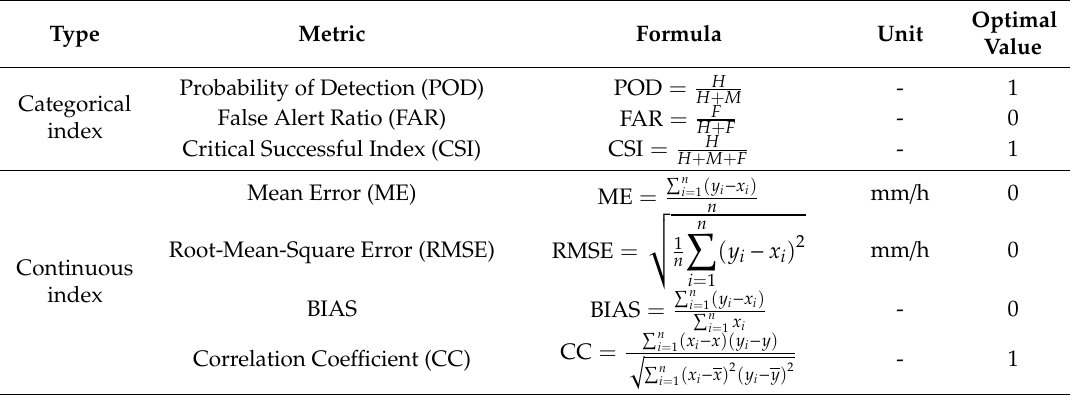
Table 3. List of the statistical metrics for Integrated Multi-satellitE Retrievals for the Global Precipitation Measurement mission IMERG (IMERG)